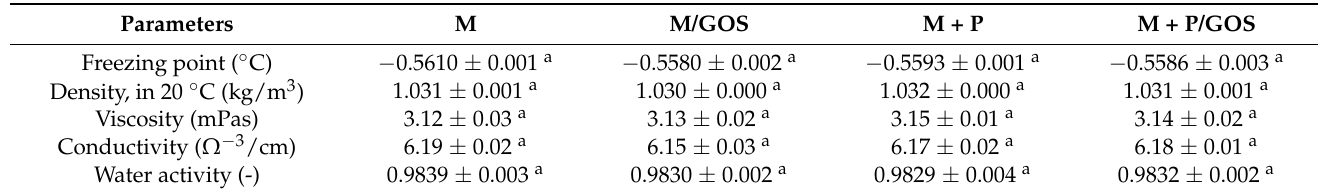
Table 3. Physicochemical properties of goat’s milk and goat’s milk with permeate after enzymatic conversion of lactose.